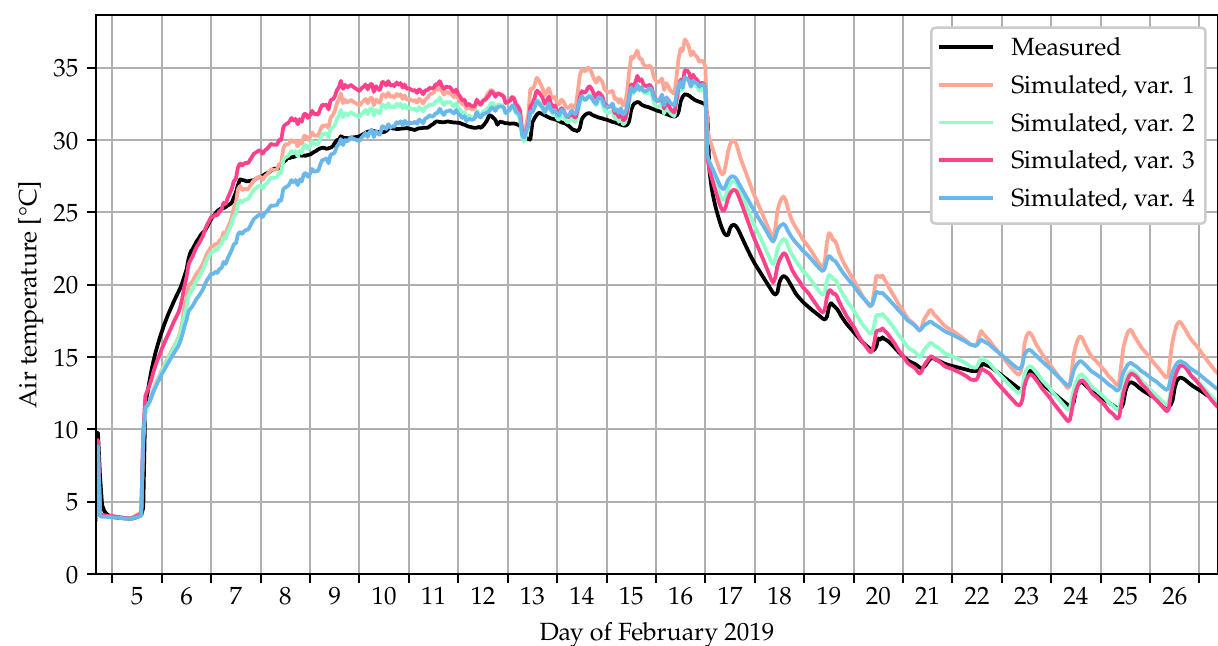
Figure 5. Mean air temperature of the heated zone of the case study building during the measurement campaign in February 2019, measured and simulated using model variations 1 to 4 (see Section 2.4).